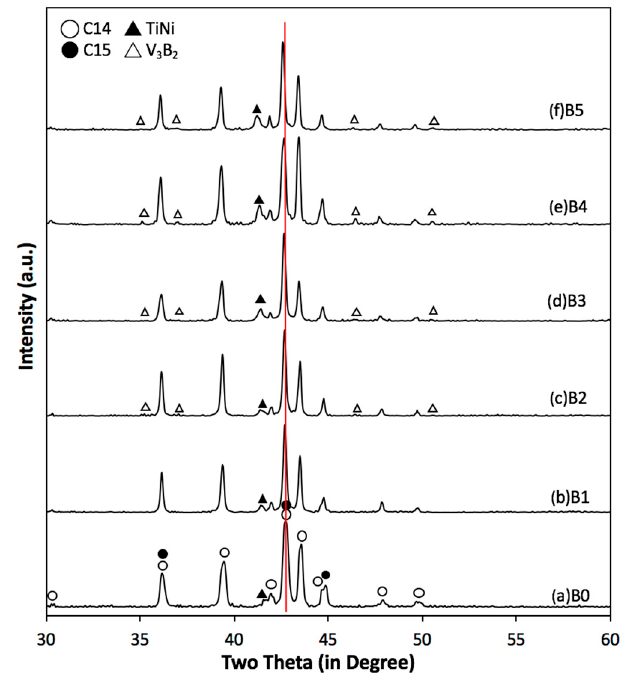
Figure 1. XRD patterns using Cu-K α as the radiation source for alloys ( a ) B0; ( b ) B1; ( c ) B2; ( d ) B3; ( e ) B4; and ( f ) B5. Besides the two Laves phases, a cubic phase (TiNi) and a tetragonal phase (V 3 B 2 ) can also be identified. Vertical line indicates the main C14/C15 peak shifting into a lower angle with the increase in the boron content.